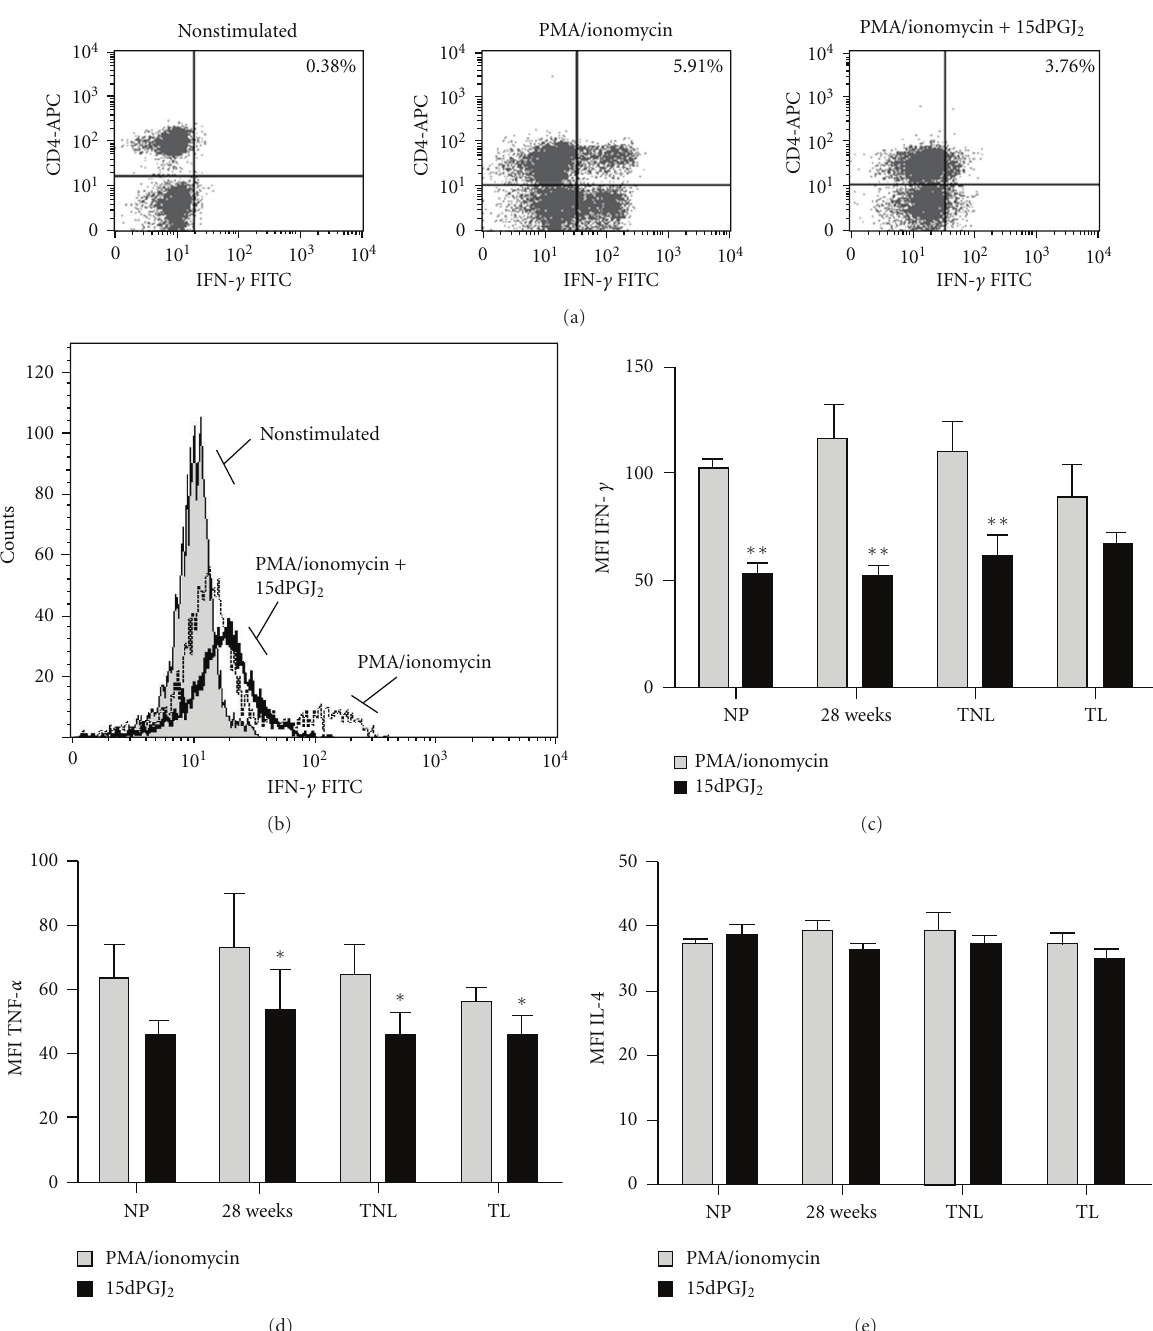
Figure 3: E ff ect of 15dPGJ2 on Th1 and Th2 cytokines. Peripheral blood mononuclear cells were incubated with vehicle control or 32 μ M of 15dPGJ 2 and stimulated with PMA/ionomycin before being gated on the lymphocyte population according to forward and side scatter. A representative 28-week patient sample is presented with CD4 + /IFN- γ + cells shown in the right upper quadrant (a). A representative histogram reveals a clear shift to the right upon stimulation indicative of increased IFN- γ producing cells (b). This e ff ect was attenuated with 15dPGJ 2 pre-treatment. PMA/ionomycin induced IFN- γ and TNF- α production was decreased with 15dPGJ 2 treatment (c) and (d); however, levels of IL-4 remained unchanged. No change in IL-4 producing cells was detected (e). For statistical analysis a Student’s t -test was used to compare means between paired treated and nontreated samples; ∗∗ P < 0 . 01 and ∗ P < 0 .